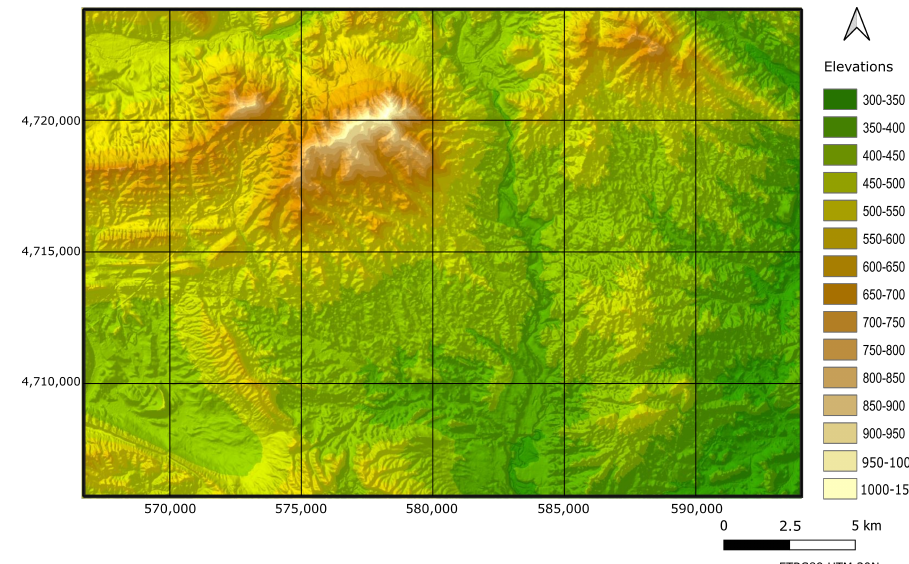
Figure 2. Map of the zone of Allo in Navarra